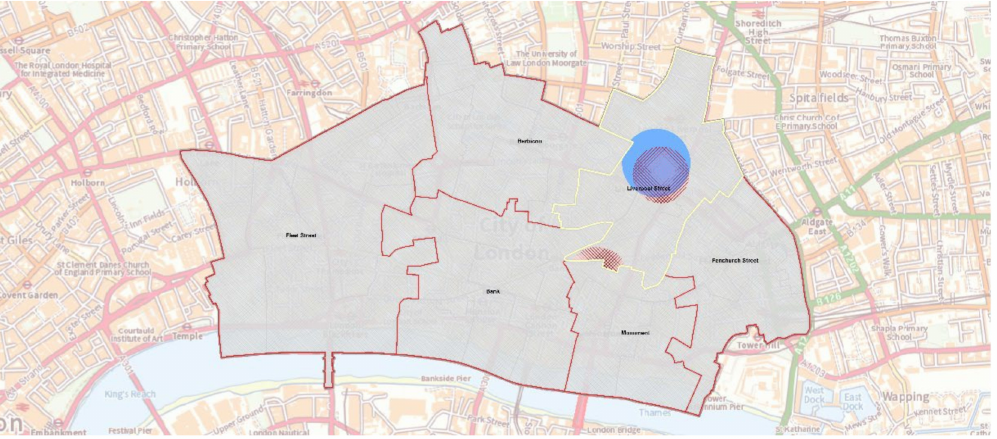
Figure 11. Shoplifting hot spots in the Liverpool Street cluster for the years 2017 (marked in blue) and 2018 (marked in red).